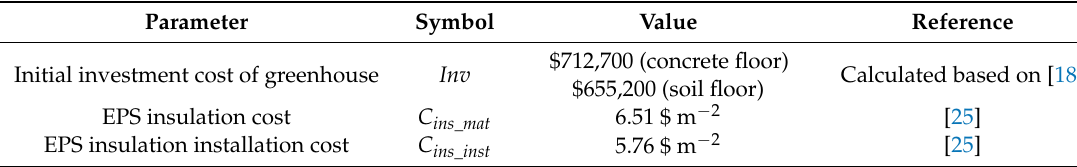
Table 2. Values of the cost data used in the